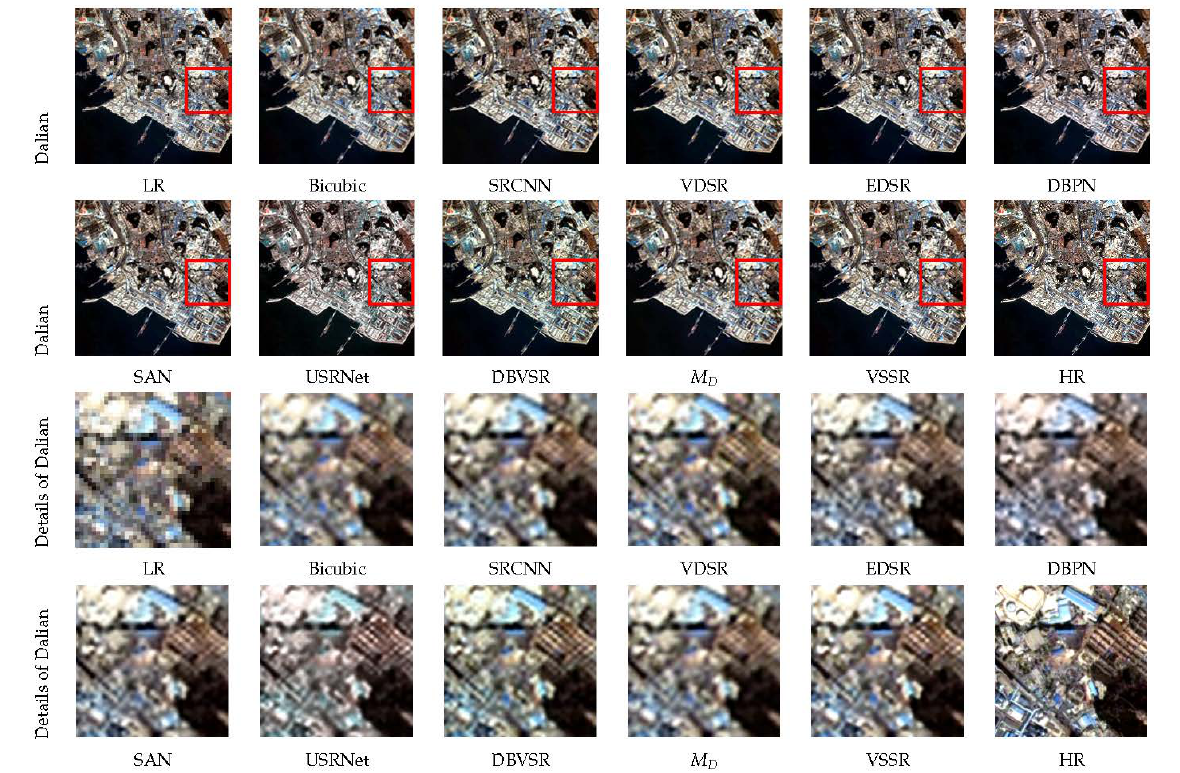
Figure 12. Reconstruction results on the third frame of Dalian (OVS-1 data) by the scale factor of × 4.